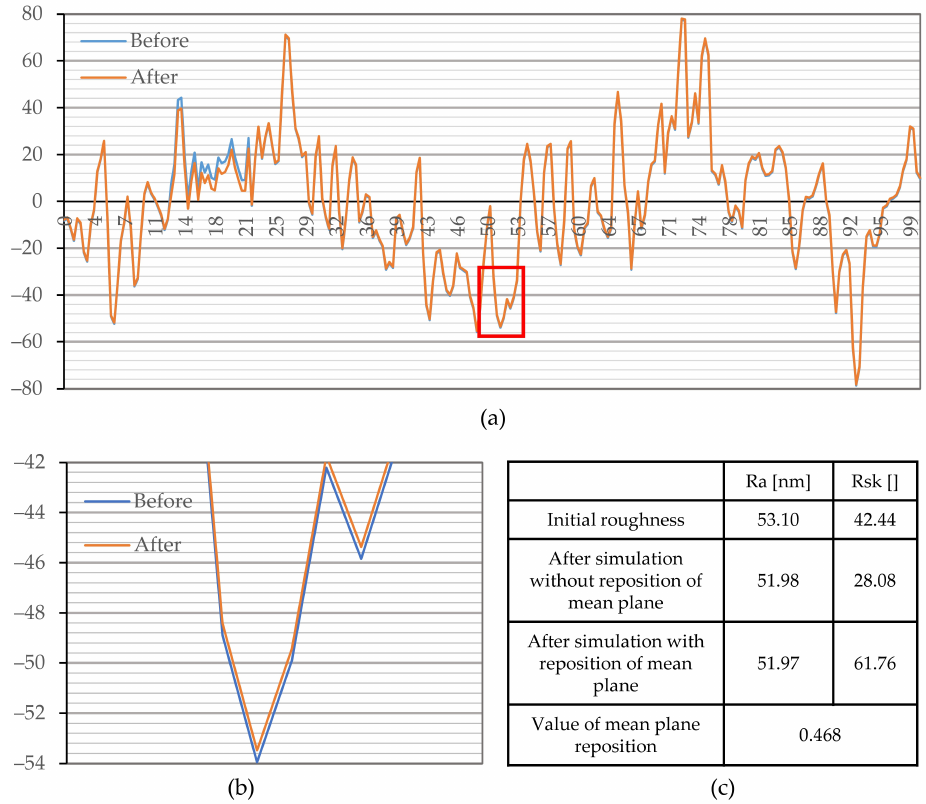
11. Simulation of localized and high-intensity corrosion attack (Simulation 1): ( a ) profiles employed for analysis; ( b ) magnified marked location, on the profile employed for analysis, that depicts relative size of mean plane repositioning; ( c ) change in tracked